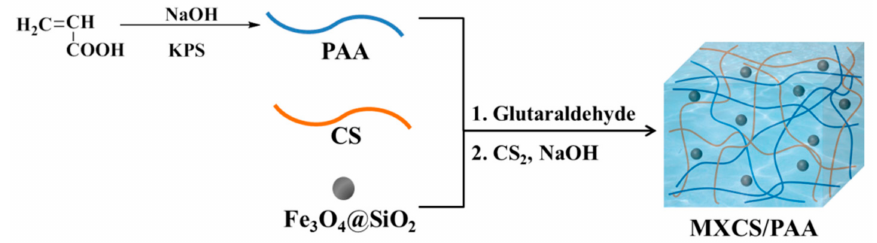
Figure 1. Synthesis route of MXCS/PAA.